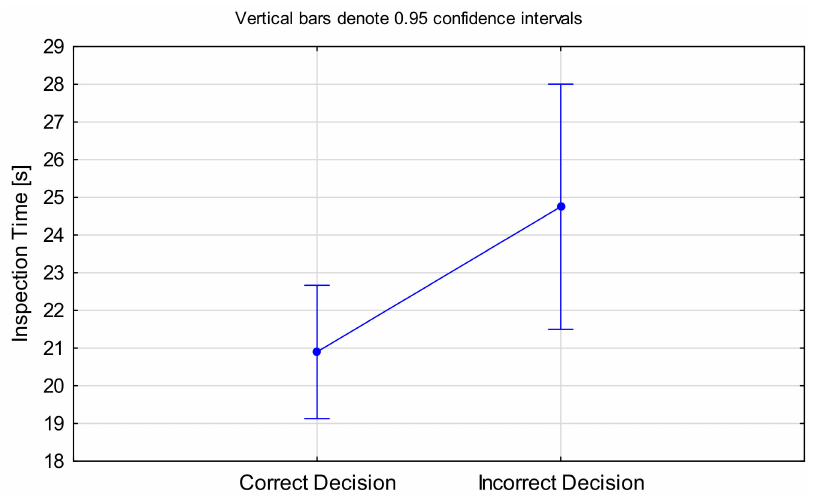
Figure 5. Mean plot of inspection time by